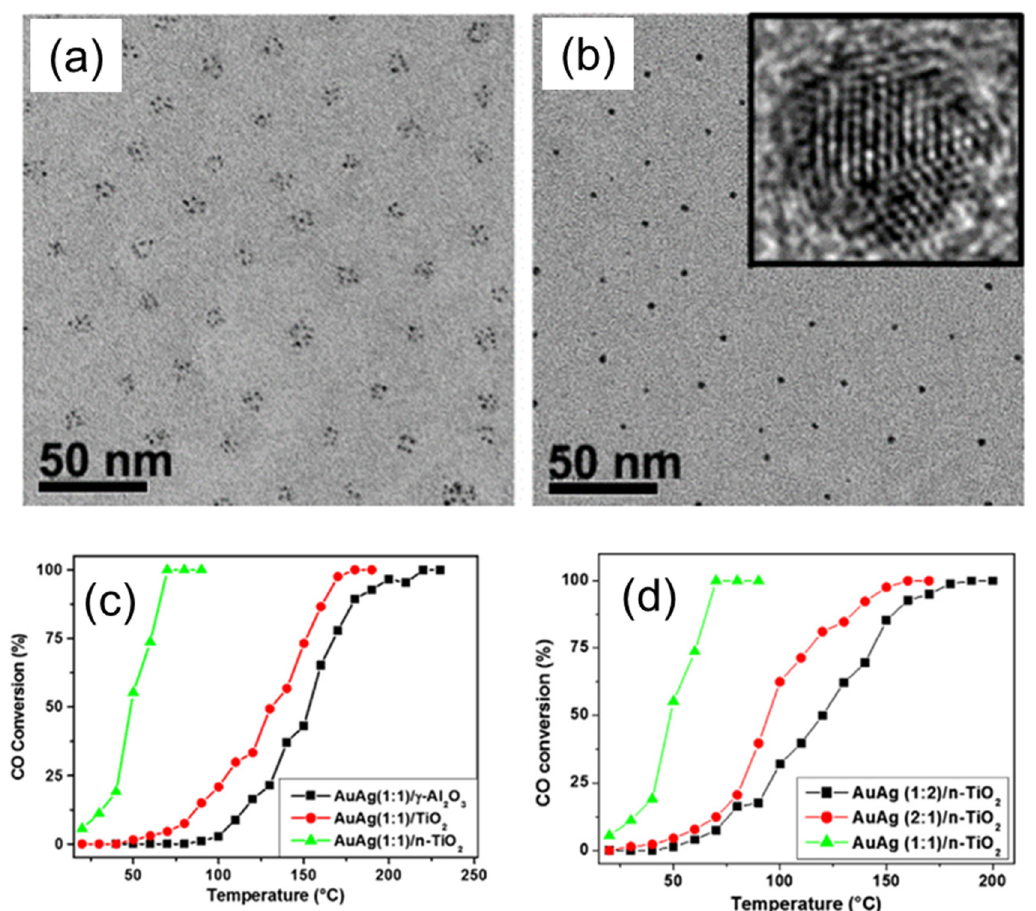
Figure 8. ( a , b ) TEM images of the bimetallic AuAg NPs ( a ) before and ( b ) after reduction. The inset shows an HRTEM image obtained for one single NP in ( b ). ( c , d ) Catalytic activity of AuAg bimetallic NPs with 1:1 ( c ) and 1:2 ( d ) Au/Ag atomic ratios, deposited on γ -Al 2 O 3 (black), regular TiO 2 (red), and BCP templates derived nanostructured n–TiO 2 during catalytic CO oxidation measured at different temperatures. Reproduced from [29].